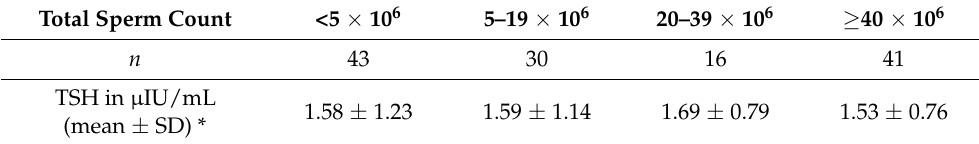
Table 1. Total sperm count of the subjects.